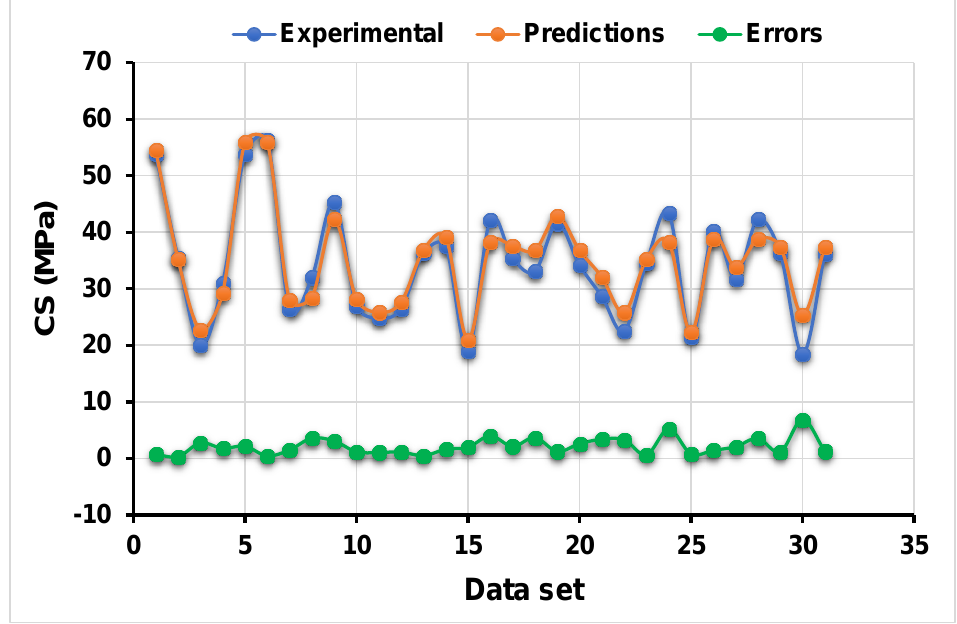
Figure 7. Error distribution of the targeted and predicted results from AdaBoost approach.